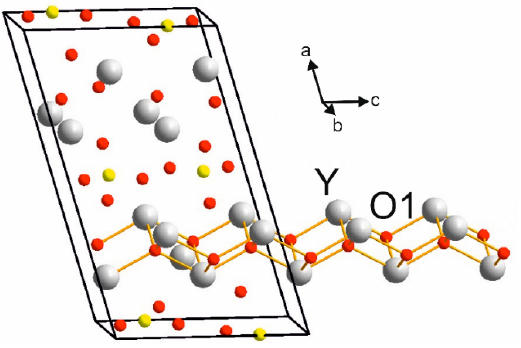
Figure 7. Representation of [Y 2 O 22+ ] layers in crystal structure of Y 2 O 2 SO 4 .